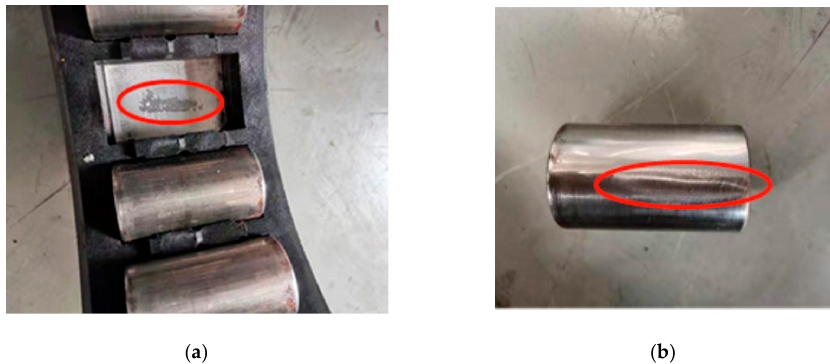
Figure 13. The photo of faulty axle box bearing. ( a ) Bearing outer ring failure. ( b ) Bearing rolling element failure.